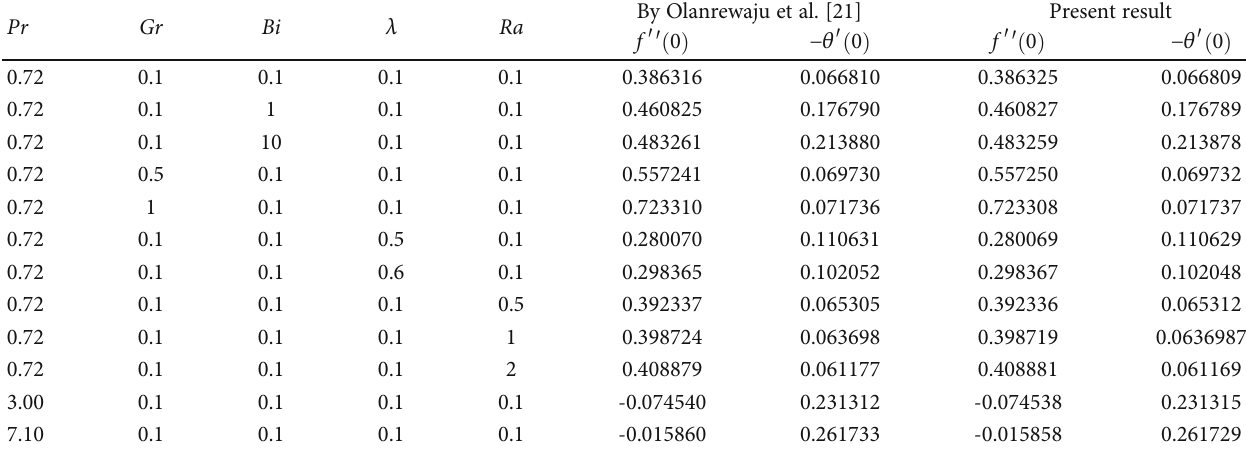
Table 1: Comparison of value of the skin-friction coe ffi cient and the Nusselt number obtained by OHAM with numerical solutions reported by other researchers for various parameters.